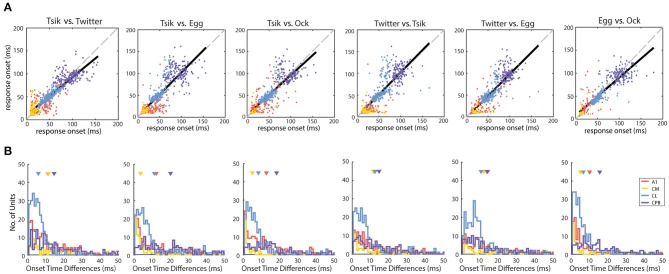
Distribution of response onset time differences between calls in different auditory cortical areas. (A) The unit-specific response onset for a pair of calls was plotted against each other (pair being compared is shown above each panel). The color of the dots indicates the population of the units. The solid black line indicates the linear regression line of the response onset. The dotted gray line indicates the line of unity. Note that in most comparisons, the regression line is very close to the line of unity. (B) The unit-specific difference in response onset between a pair of calls was calculated for all units that responded to the two calls being compared (pair being compared is shown above each panel). The distributions of these unit-specific differences in response onset time listed are plotted for each of the cortical areas (different colors for the different populations). In each panel the triangles indicate the mean onset time differences for each of the areas. Note that in all comparisons, the great majority of units showed differences of <10 ms between response onsets for any pair of calls, even in cortical areas with later response onsets (CL and CPB).